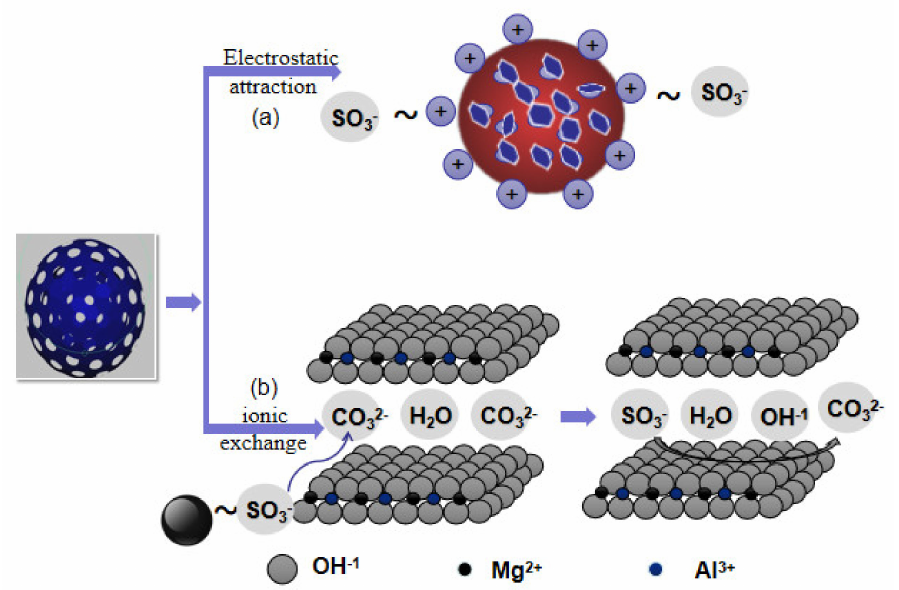
Figure 15. A possible mechanism for the adsorption of sulfonated lignite by biomorphic filter paper-templated Mg-Al metal oxides; ( a ) electrostatic attraction; ( b ) ionic